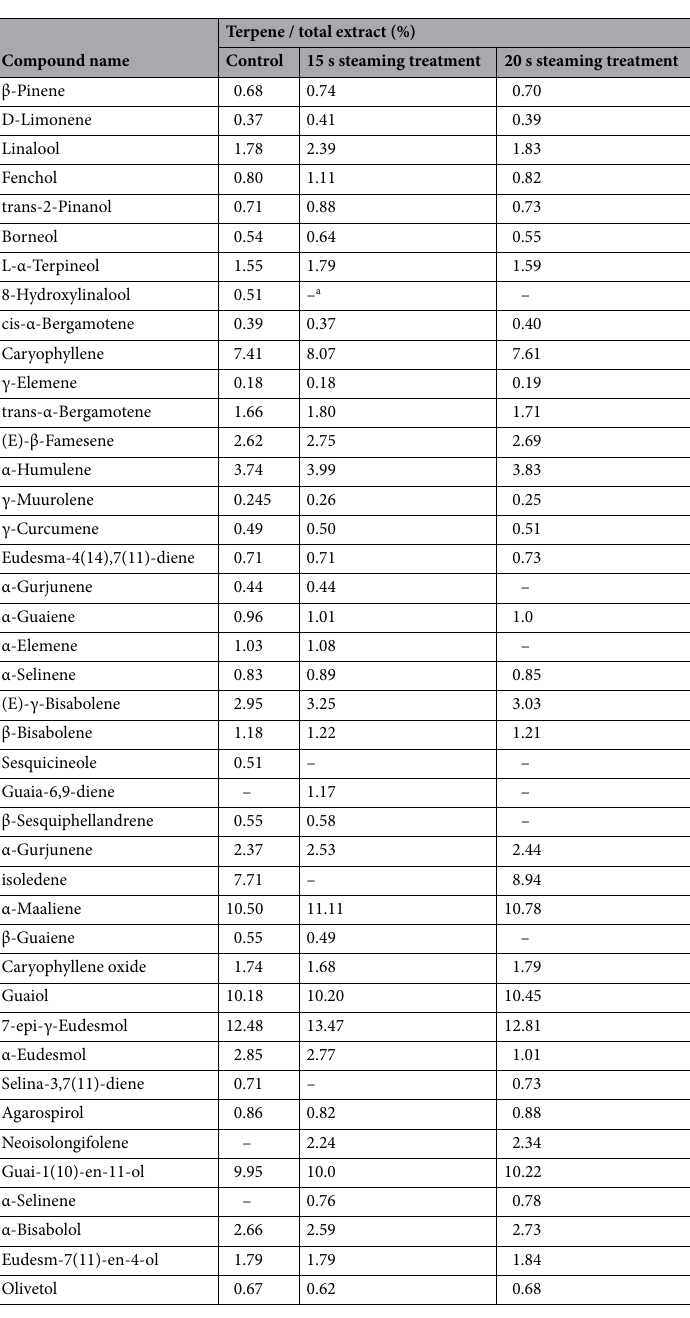
Table 6. List of terpenes and terpenoids and their relative amounts detected by GC–MS from the third commercial experiment. a Concentration below detection